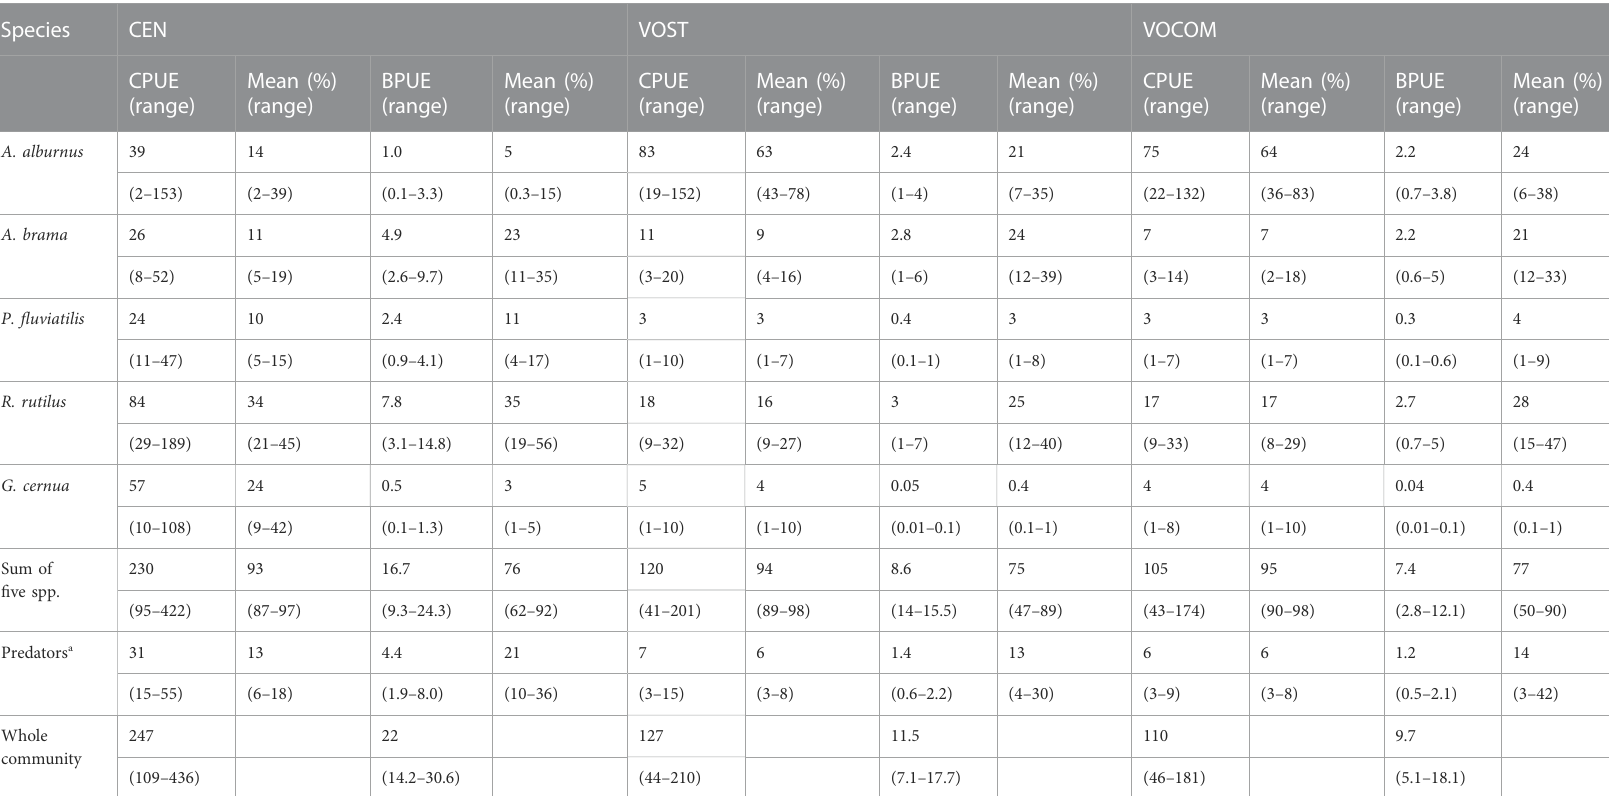
TABLE 3 Average whole-reservoir CPUEs (ind./1,000 m 2 net) and BPUE (kg/1,000 m 2 net) from the gillnet catch and percentage contribution of fi ve most dominant species and predators in Ř ímov Reservoir (Czech Republic) obtained using the three different weighting methods.